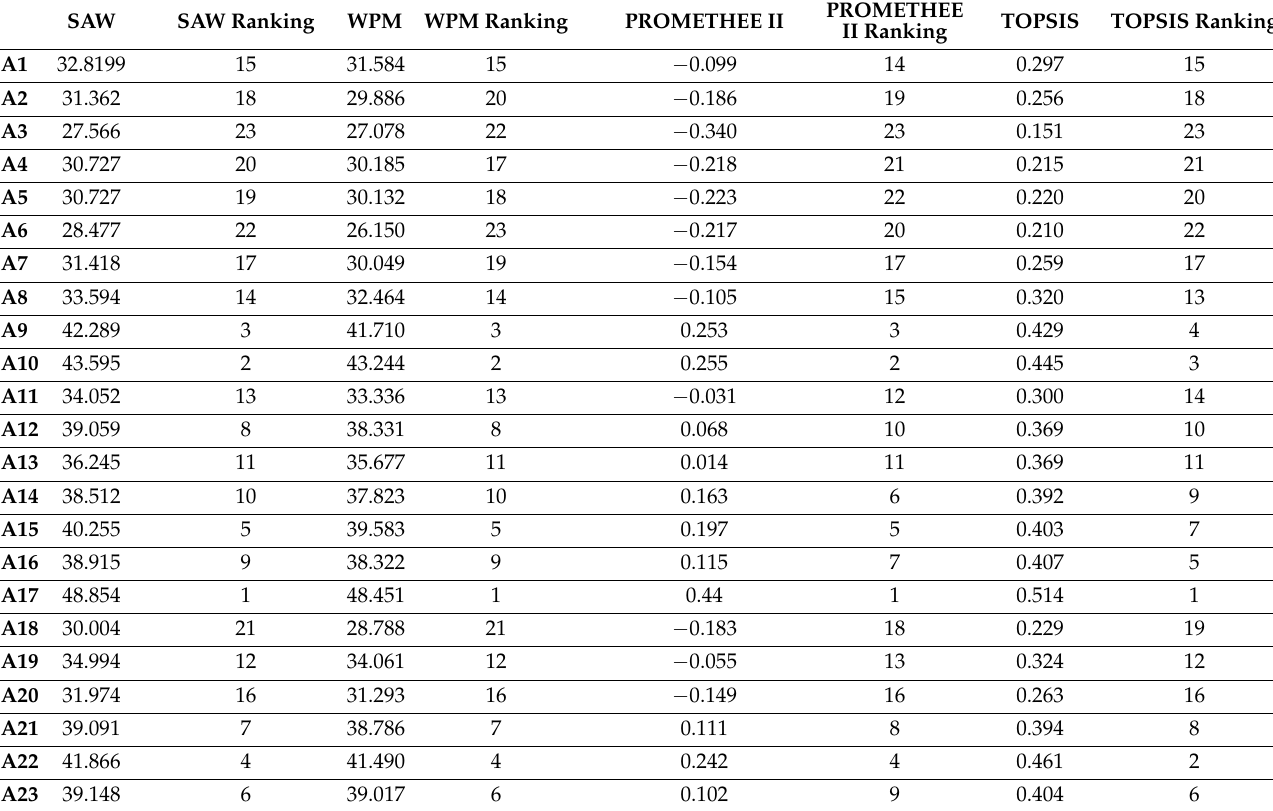
Table 4. Values and Ranking for all websites using SAW, WPM, TOPSIS and PROMETHEE